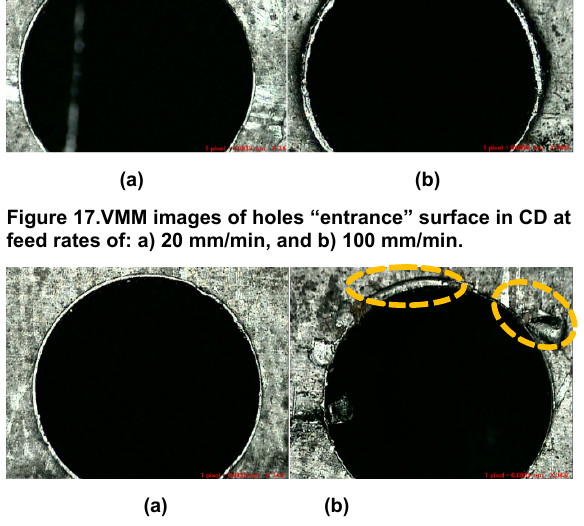
Figure 18.VMM images of holes’ end surface in CD at feed rates of: a) 20 mm/min, and b) 100